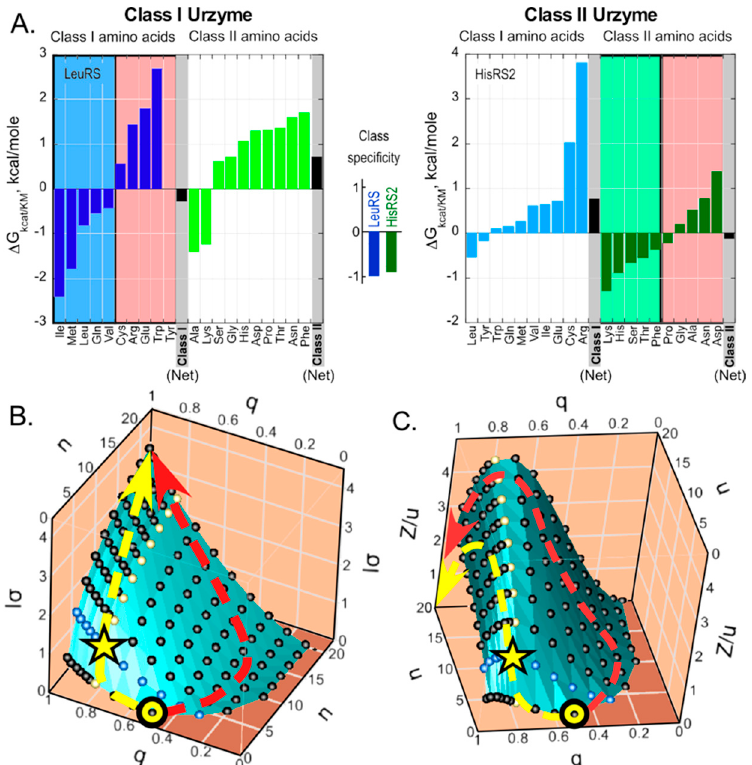
Figure 4. ( A ) Experimental data for comparison with theoretical results derived here. Amino acid specificity spectra for Class I LeuRS and Class II HisRS Urzymes. ( B ) Effects of fidelity (q) and alphabet size (n) on the amount of information transferred per monomer upon synthesis of a polymer from a template (i.e., either replication, transcription, or translation) calculated using the formula for I σ , Eqn (7). C. Variation of the impedance parameter, Z/u on the {n, q} surface. Points are simulated on the n/q grid using Eqn (15). In ( B , C ), blue dots are those for a nucleic acid template with four letters; yellow dots indicate the locus of all points with q = 0.8, which represents the ridge over which the impedance parameter in C is maximal for any value of q. Continuous q values are sampled from 0.001 up to 0.999~1.0. Points in the {n,q} plane where q < 1/n have no coding significance, and are darkened to indicate idling behavior. Yellow and red dashed arrows suggest alternate paths. Both paths begin at the yellow circle with a binary alphabet and a minimal q × n value ~ 1.0.